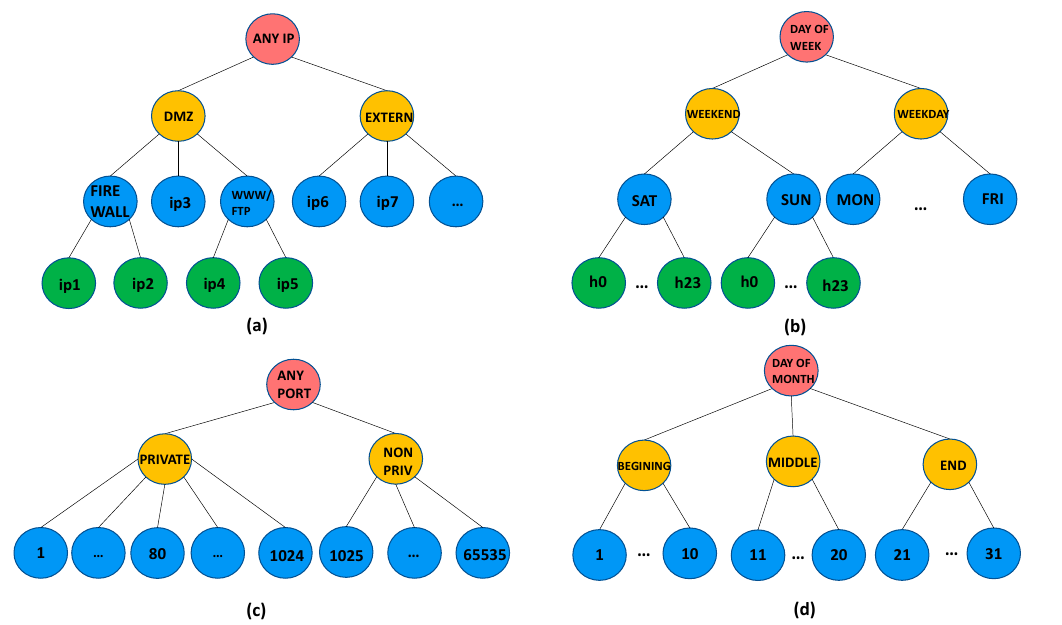
Figure 1. Hierarchical tree structure of four attributes: ( a ) IP address attribute; ( b ) time attribute measured in weeks; ( c ) port number attribute; ( d ) time attribute measured in months.